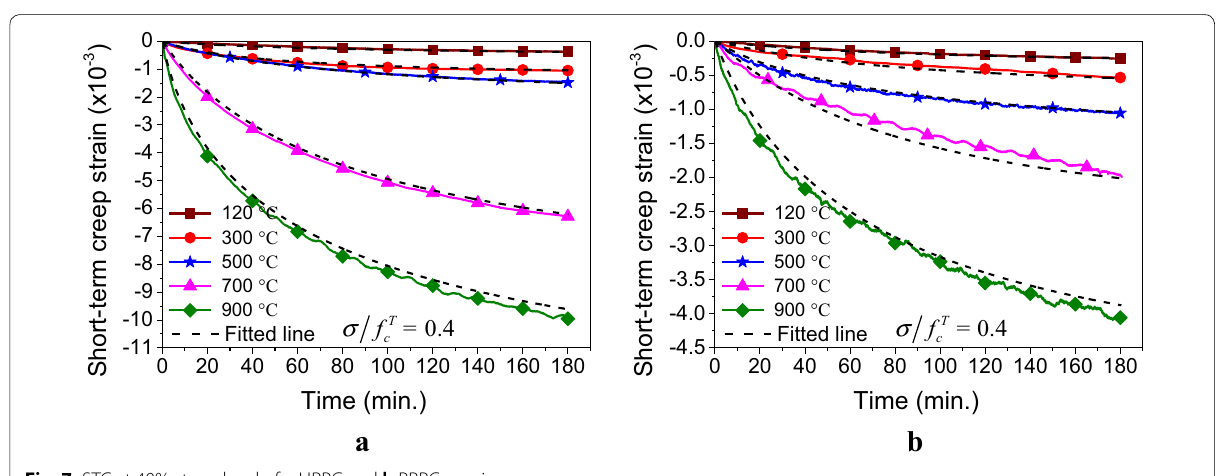
Fig. 7 STC at 40% stress level of a HRPC and b PRPC